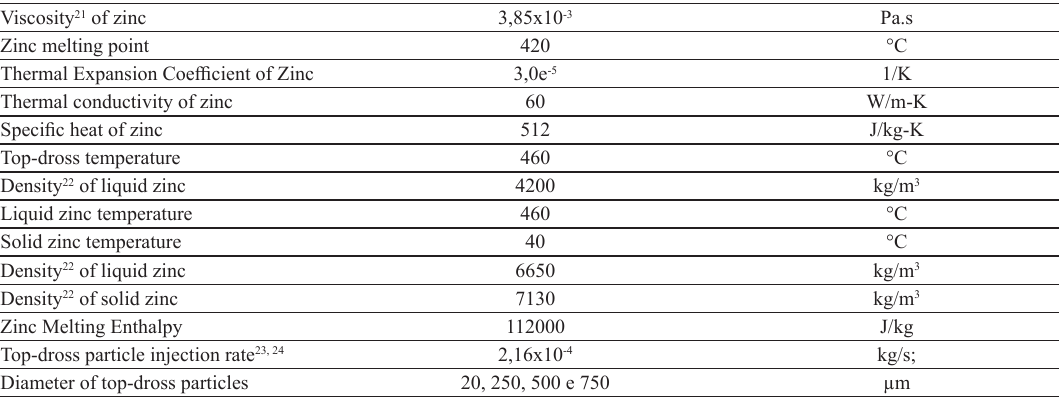
Table 1. Properties of top-dross particles and molten zinc.